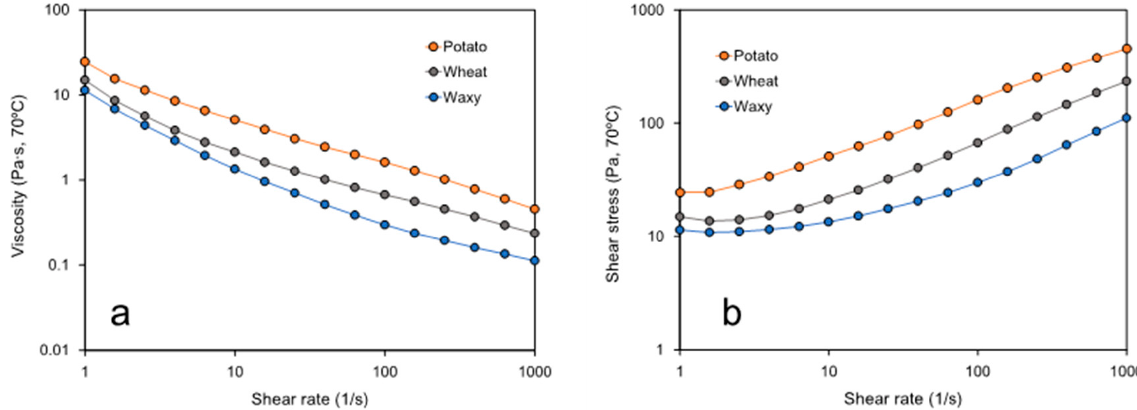
Figure 2. Flow curve in gelatinized pure starch samples (0%CNC) at 70 °C: ( a ) apparent viscosity and ( b ) shear stress as a function of shear rate.